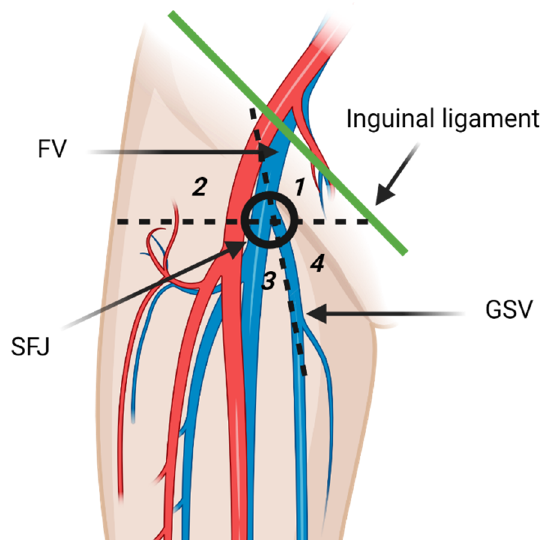
Figure 2. Diagrammatic illustration of the superficial inguinal lymph nodes anatomy. The superficial inguinal lymph nodes are inferior to the inguinal ligament and divided in five groups by the greater saphenous vein (GSV) and a horizontal line through the saphenofemoral junction (SFJ). The five groups are superior medial ( 1 ), superior lateral ( 2 ), inferior lateral ( 3 ), inferior medial ( 4 ), and central group that overlies the SFJ. FV: femoral vein. The inferolateral group receives most of the lymphatic drainage of the lower extremity. “Created by BioRender.com. accessed on 10 August 2021”.